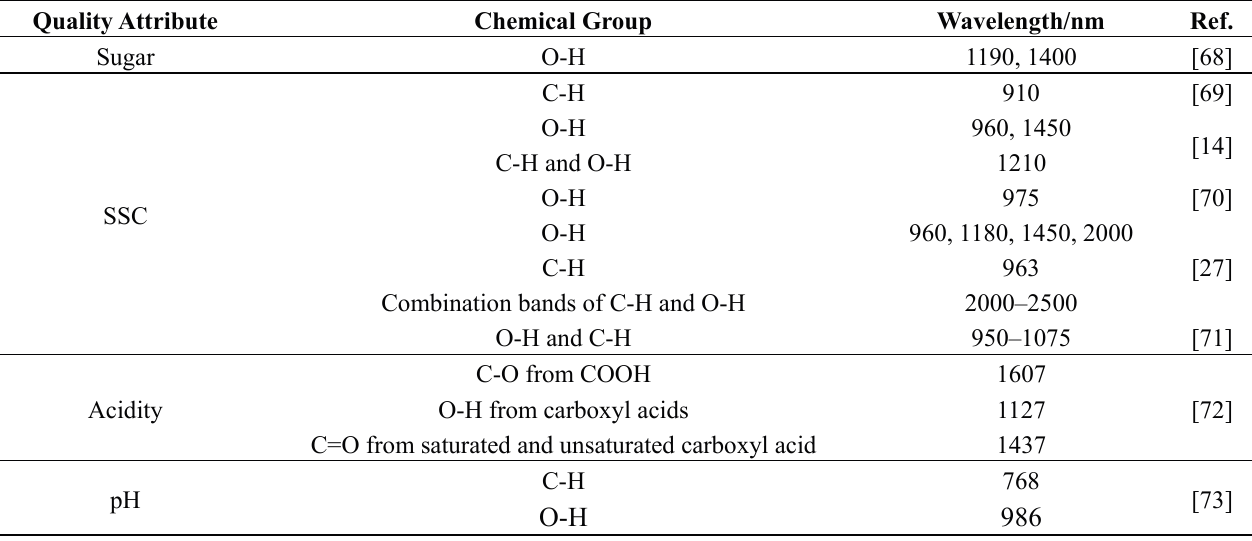
Table 1. Overview of wavebands containing typical absorption bands for certain chemical groups.